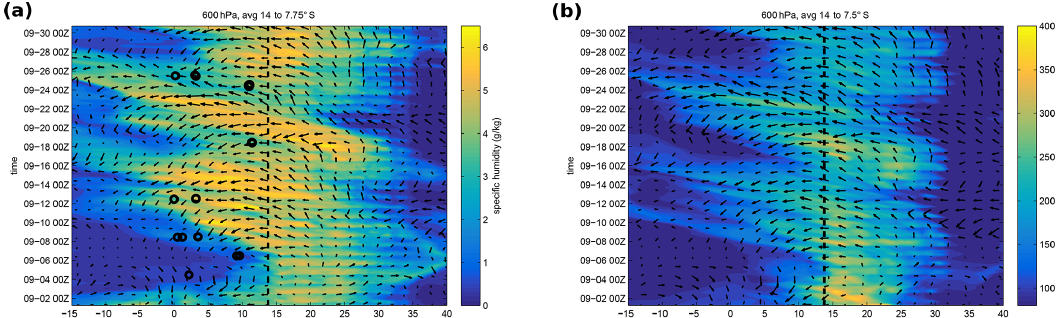
Figure 9. Hovmöller plot showing the development and transport of air masses from continental Africa over the SEA, with colors showing (a) water vapor from ERA-5 and (b) carbon monoxide from MERRA-2, at 600hPa ( ∼ 4.4km), based on 3-hourly time steps. The location of the African shoreline in this region is indicated by the dashed black line, and data are averaged between 7.75 and 14 ◦ S (note the domain is slightly larger for MERRA-2 due to the model resolution). Black circles show the locations and times of ORACLES aircraft profiles within this region. In the east (right-hand side) of each plot, the diurnal convection cycle is evident, showing increased water vapor (CO) at this altitude during the daytime; in the west (left-hand side), episodes of water vapor (CO) are seen as these continental air masses are advected by the AEJ-S. Wind vectors do not scale between the two panels, although the patterns are seen to be largely similar between the two